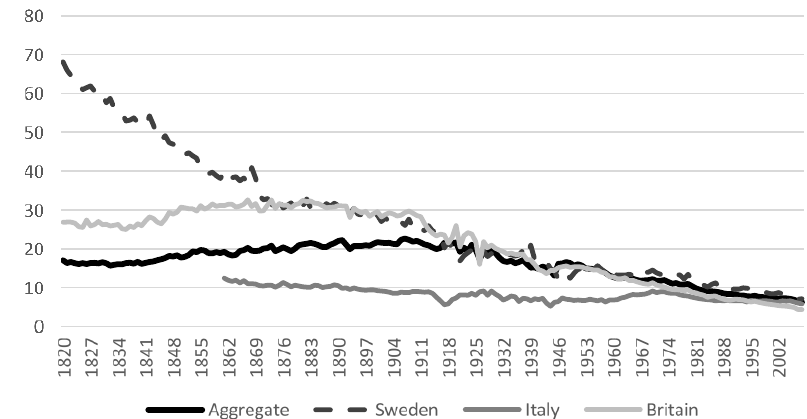
Figure 2. Energy intensity for Europe 1820–2009, MJ/international dollar in 1990 prices. Source: [3,15] The aggregate energy intensity includes Britain, France, Germany, Italy, the Netherlands, Portugal, Spain, and Sweden. Prices are in constant international dollars, calculated at PPP (purchasing power parity) in 1990.